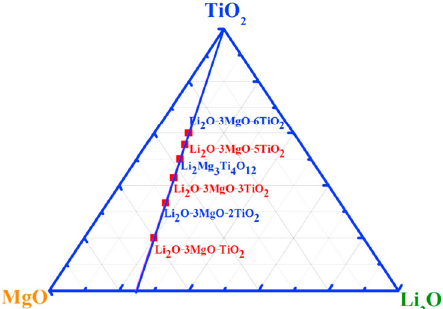
Fig. 10 Ternary phase diagram of Li 2 O–3MgO– m TiO 2 systems. Reproduced with permission from Ref. [279], © Elsevier Ltd and Techna Group S.r.l.